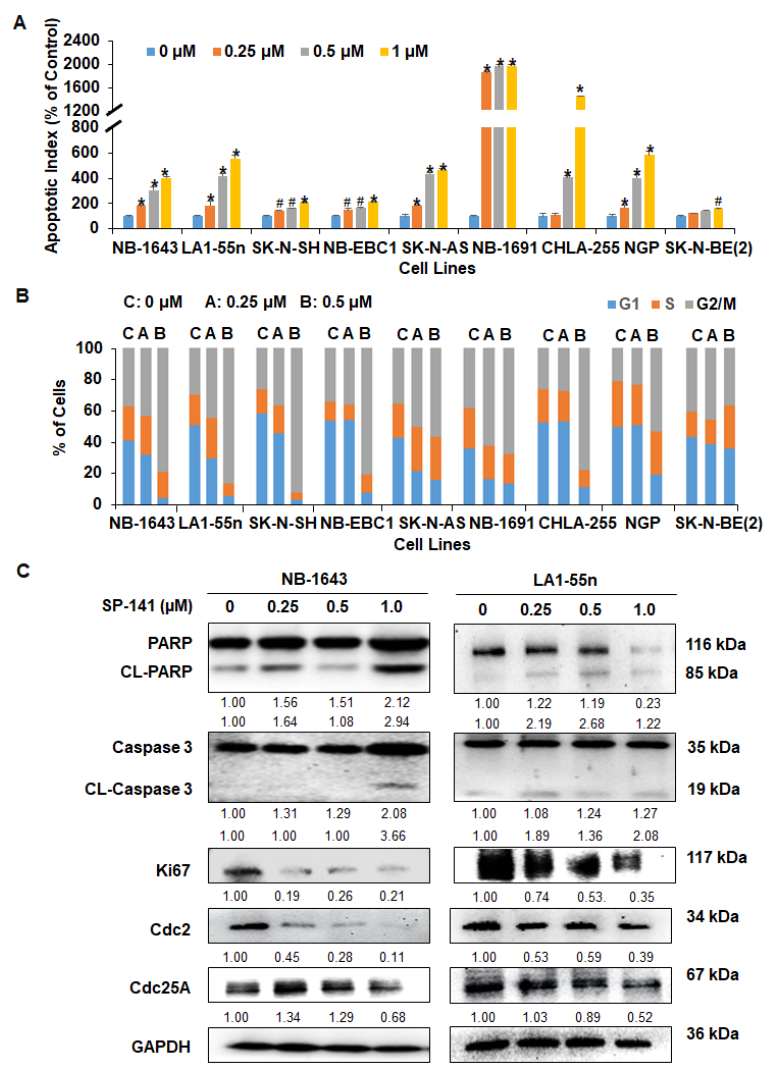
Figure 2. SP141 induces apoptosis and cell cycle arrest in neuroblastoma cells, independent of p53.